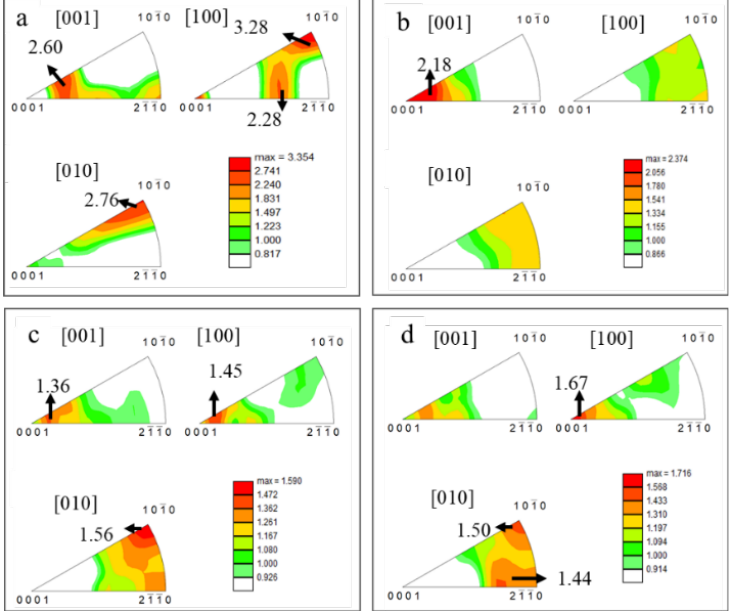
Figure 8. IPFs at various deformation positions at 760 °C: ( a ) at the grip position, ( b ) the gauge section near the grip, ( c ) the middle of the gauge section, and ( d ) section near the tip of the fracture.